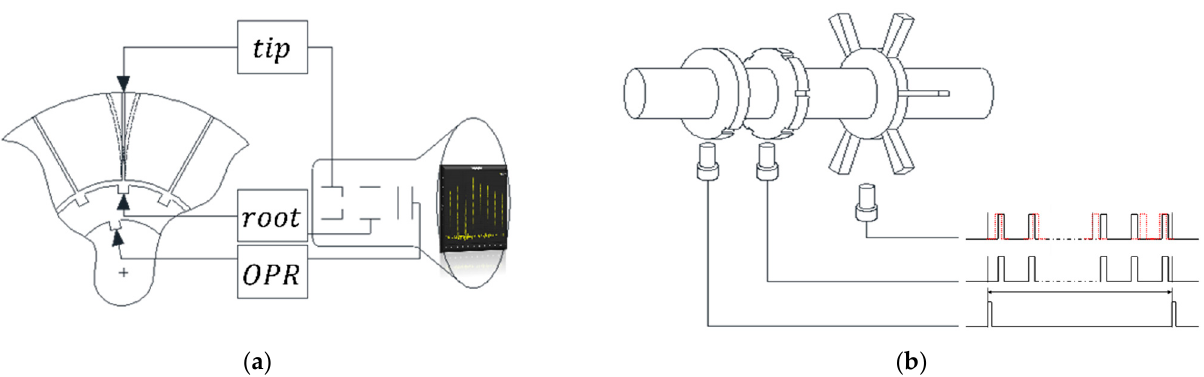
Figure 1. Reproduction of early BTT devices: ( a ) the USSR ELURA analogue device (1970) [5], ( b ) the Avco-Lycoming device (1967) [6].